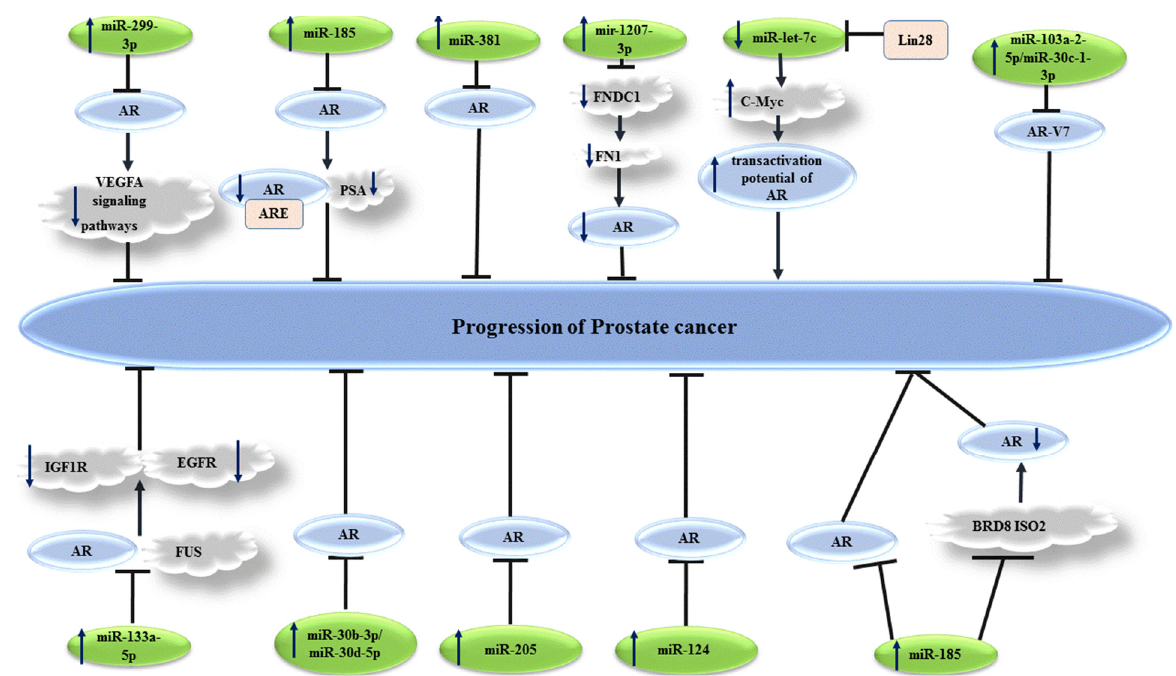
Figure 1. Several miRNAs have been shown to affect levels of androgen receptor (AR), thus influencing the progression of prostate cancer. Detailed information about these miRNAs is presented in Table 1. ( reduction or inhibition of, increased levels of, decreased levels of).